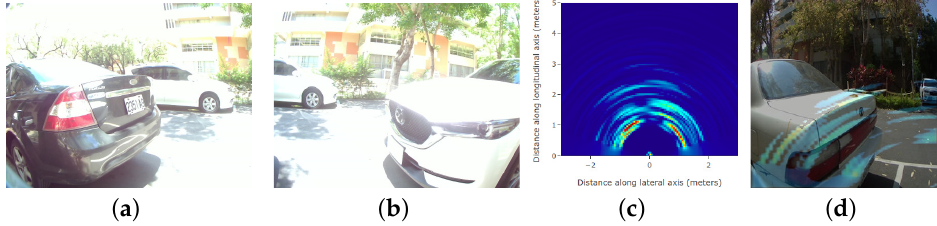
Figure 2. The fusion results of camera image and mmWave millimeter wave radar for parking meter system. ( a ) Left camera. ( b ) Right camera. ( c ) mmWaveR HeatMap. ( d ) mmWave